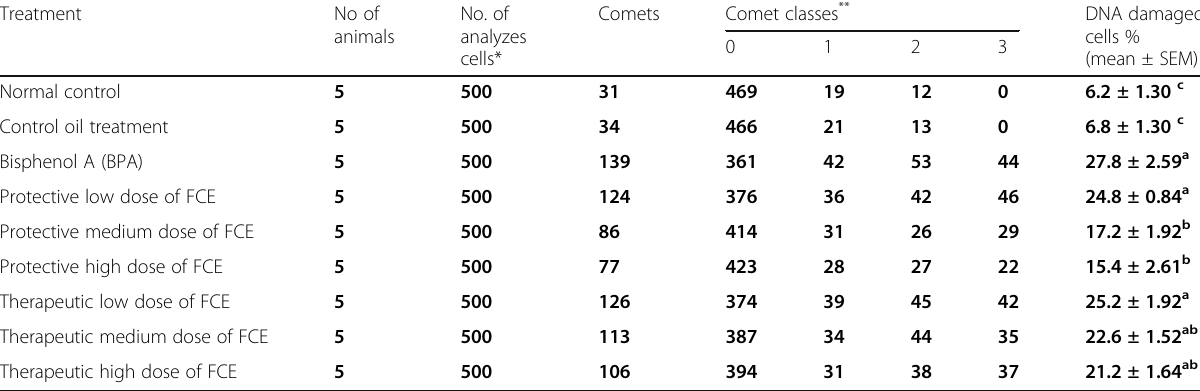
Table 1 Comet assay analysis shows the enhancement role of Fagonia cretica (FCE) on Bisphenol A-induced DNA damage in rats Treatment No of